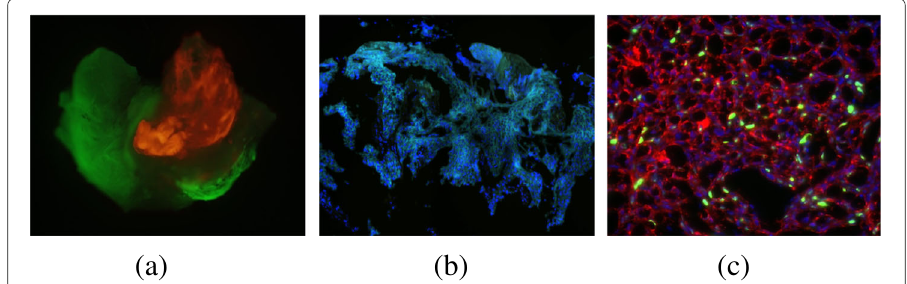
Fig. 3 Images of tumors from confetti mice at different stages of tumor development. a A benign papilloma that has retained distinct clones with no evidence of intermixing. b In the malignant carcinoma, one clone emerges to dominate in a clonal sweep. c After malignant conversion, new cell clones are generated (red and green cells) which show evidence of clone intermixing. This may facilitate the cell-cell interactions that eventually promote